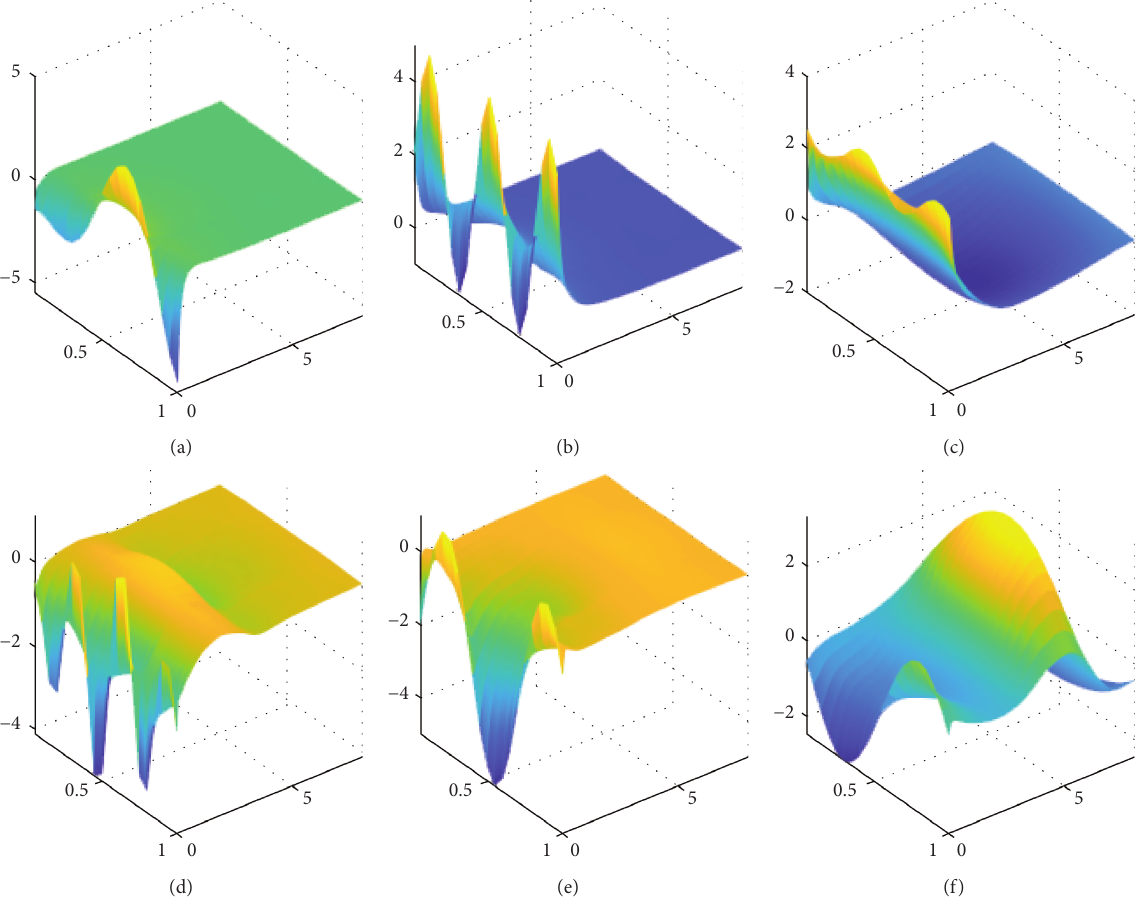
Figure 3: Real part of state error evolution under the output static event-triggered control. net11, net12, and net13 represent 3-dimensional real-valued state evolution of the 1sterror network. net21, net22, and net23 represent 3-dimensional real-valued state evolution of the 2nd error network. “real” denotes real part. (a) net11-real. (b) net12-real. (c) net13-real. (d) net21-real. (e) net22-real. (f) net23-real.